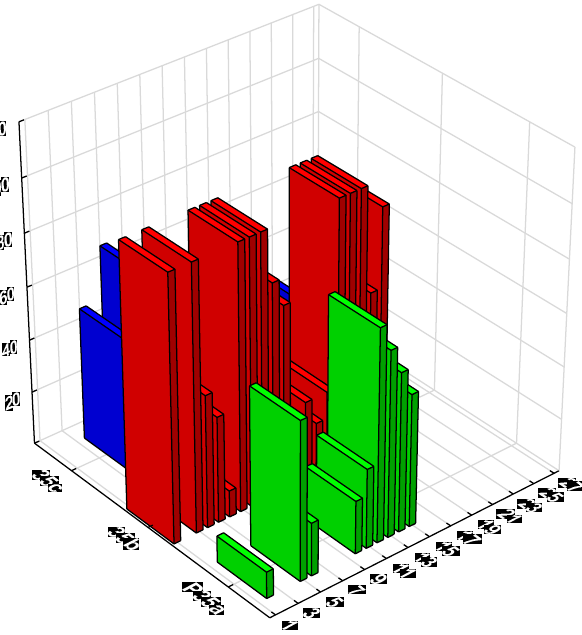
Figure 5. Supply share diagram for stores. Axis explanations: X—store number (1–20), Y—supplier: P35a—individual supplier, P35b—domestic wholesaler, P35c—foreign wholesaler, Z—supply share in percent.